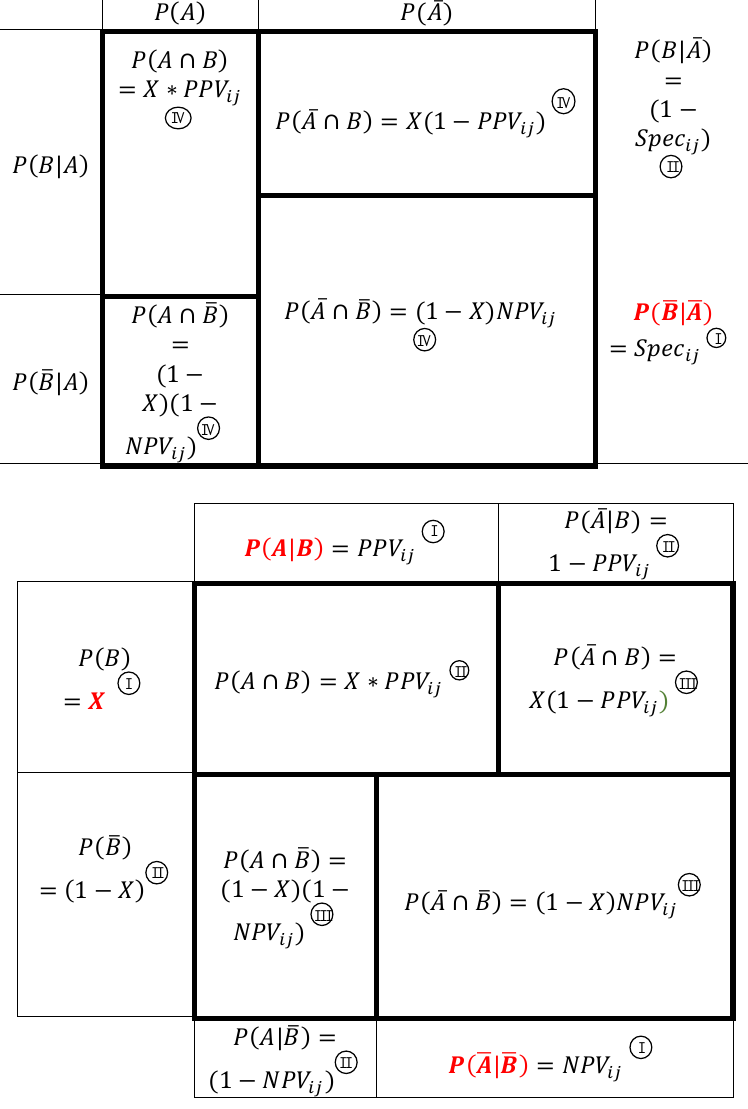
= 𝑃(𝐵|𝐴)) in terms of the specificity 𝑖𝑗 = 𝑃(𝐴|𝐵) ) and negative predictive value (𝑁𝑃𝑉 𝑖𝑗